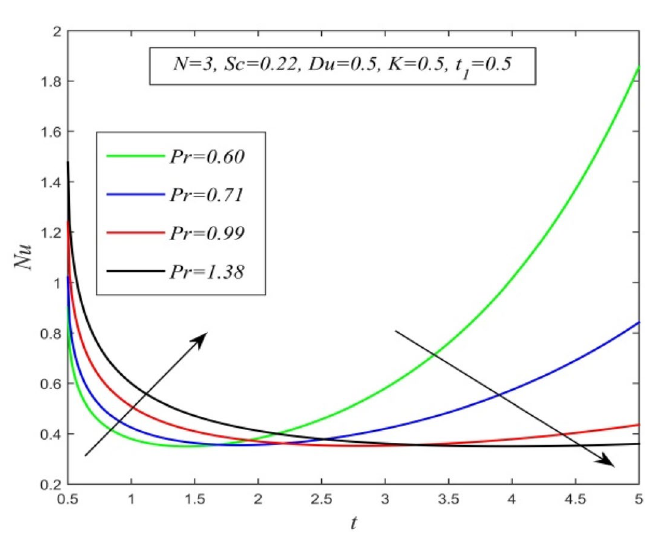
Figure 24. Nu versus t for different Pr and Sc = 0.22, N = 3, Du = 0.5, K = 0.5, t 1 =